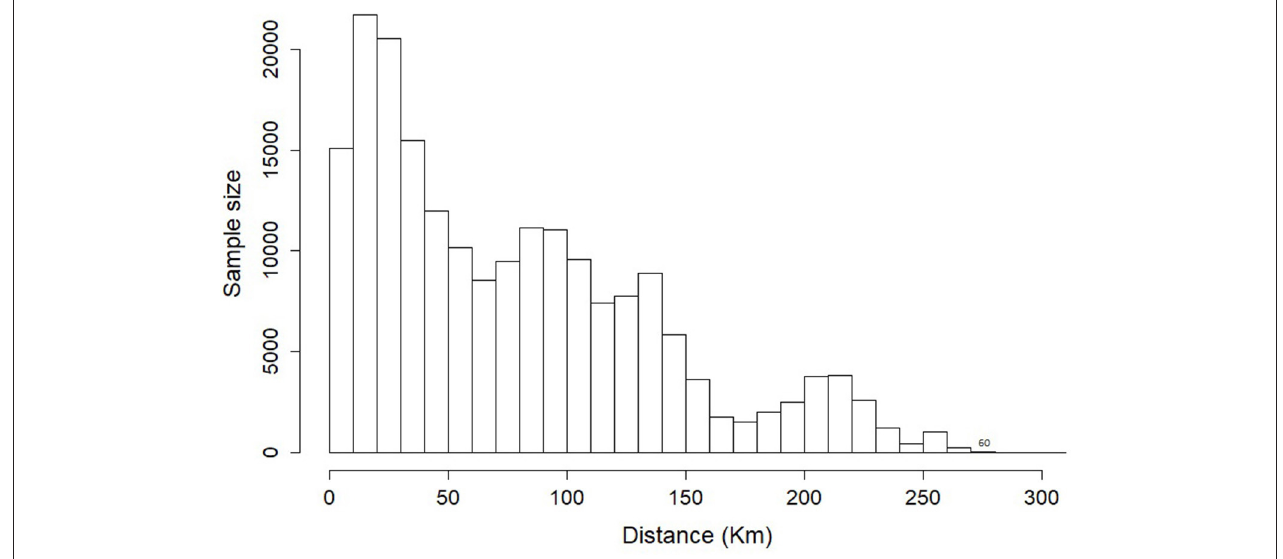
FIGURE 1 | Number of unique pairs of nestbox comparisons by 10km distance classes. Distances from 280 to 310km were pooled into a single class due to small sample size.